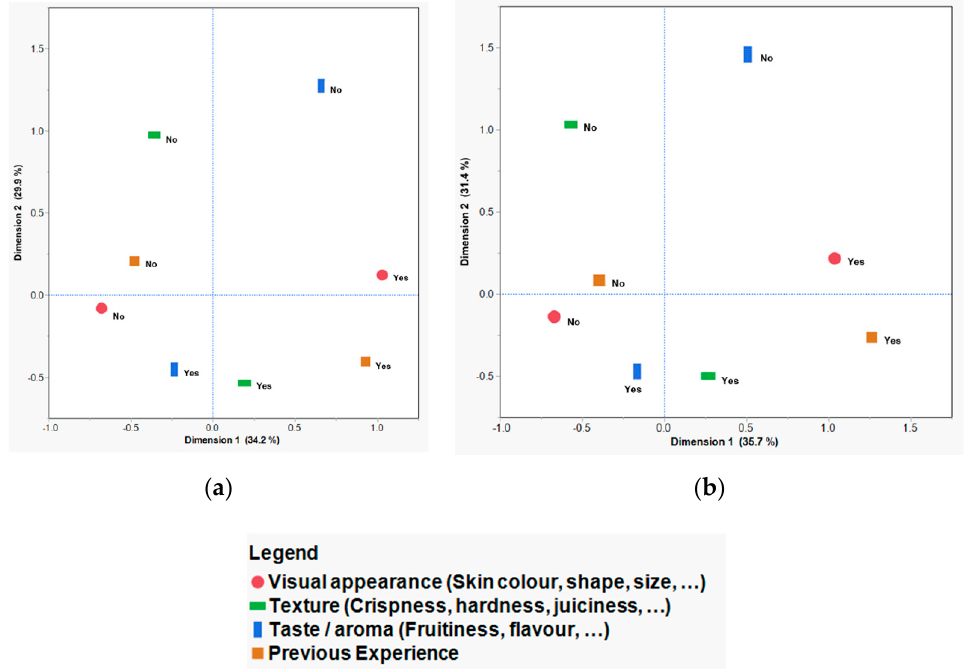
Figure 1. Multiple correspondence analysis (MCA) of retail market ( a ) and special-event market ( b ) data showing the two-dimensional plot (dimension 1 versus dimension 2), created using the four most important reasons for purchasing apples (visual appearance, texture, taste/aroma, and previous experience), as identified by consumers. Each reason was a binary variable with a yes/no response.